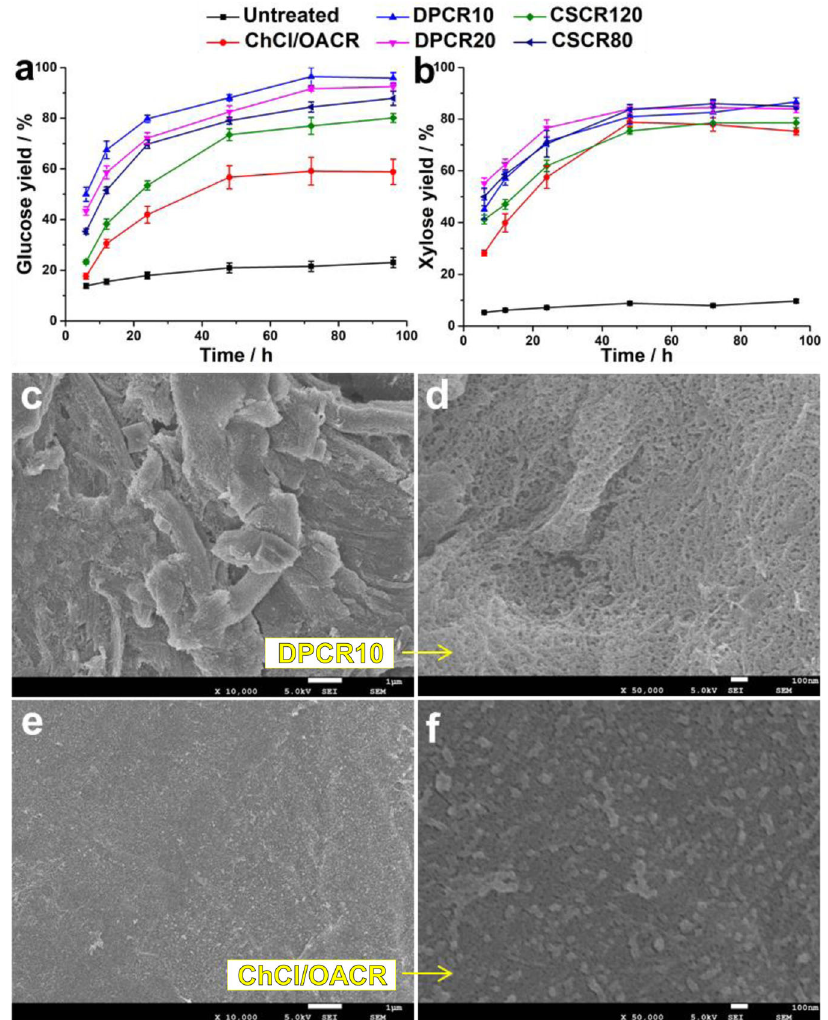
Fig. 7 Enzymolysis and SEM images of DES fractionated cellulose residues. Enzymatic hydrolysis yield of glucose ( a ) and xylose ( b ) from untreated birch lignocellulose and various DES fractionated CRs. The yield of glucose and xylose was calculated based on the cellulose and hemicellulose content in various substrates. The yields were average values from a set of at least three experiments showing standard deviations. SEM images of DP-DES10 fractionated CR at low magni fi cation ( c ) and high magni fi cation ( d ), the cell structure of DPCR10 was fi brillated and without formation of lignin particles; ChCl/OA DES fractionated CR at low magni fi cation ( e ) and high magni fi cation ( f ), showing obvious lignin particles formation (condensed lignin which is con fi rmed as shown in Supplementary Section 5.2.1, the average diameter of ~54 nm) on the